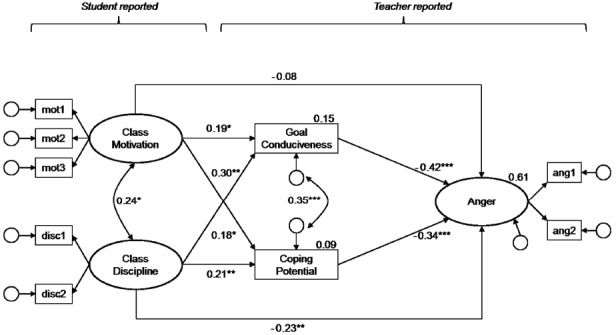
Teacher appraisals mediating the relationship between classroom conditions and teacher anger. Standardized coefficients are shown; the regression coefficients for the latent variable indicators and residuals are not displayed. Estimates at the dependent variables represent explained within-level variance (R2). Model fit: χ2 = 35.11, df = 19, p = 0.01, RMSEA = 0.05, CFI = 0.97, SRMRwithin = 0.04. *p < 0.05, **p < 0.01, ***p < 0.001.